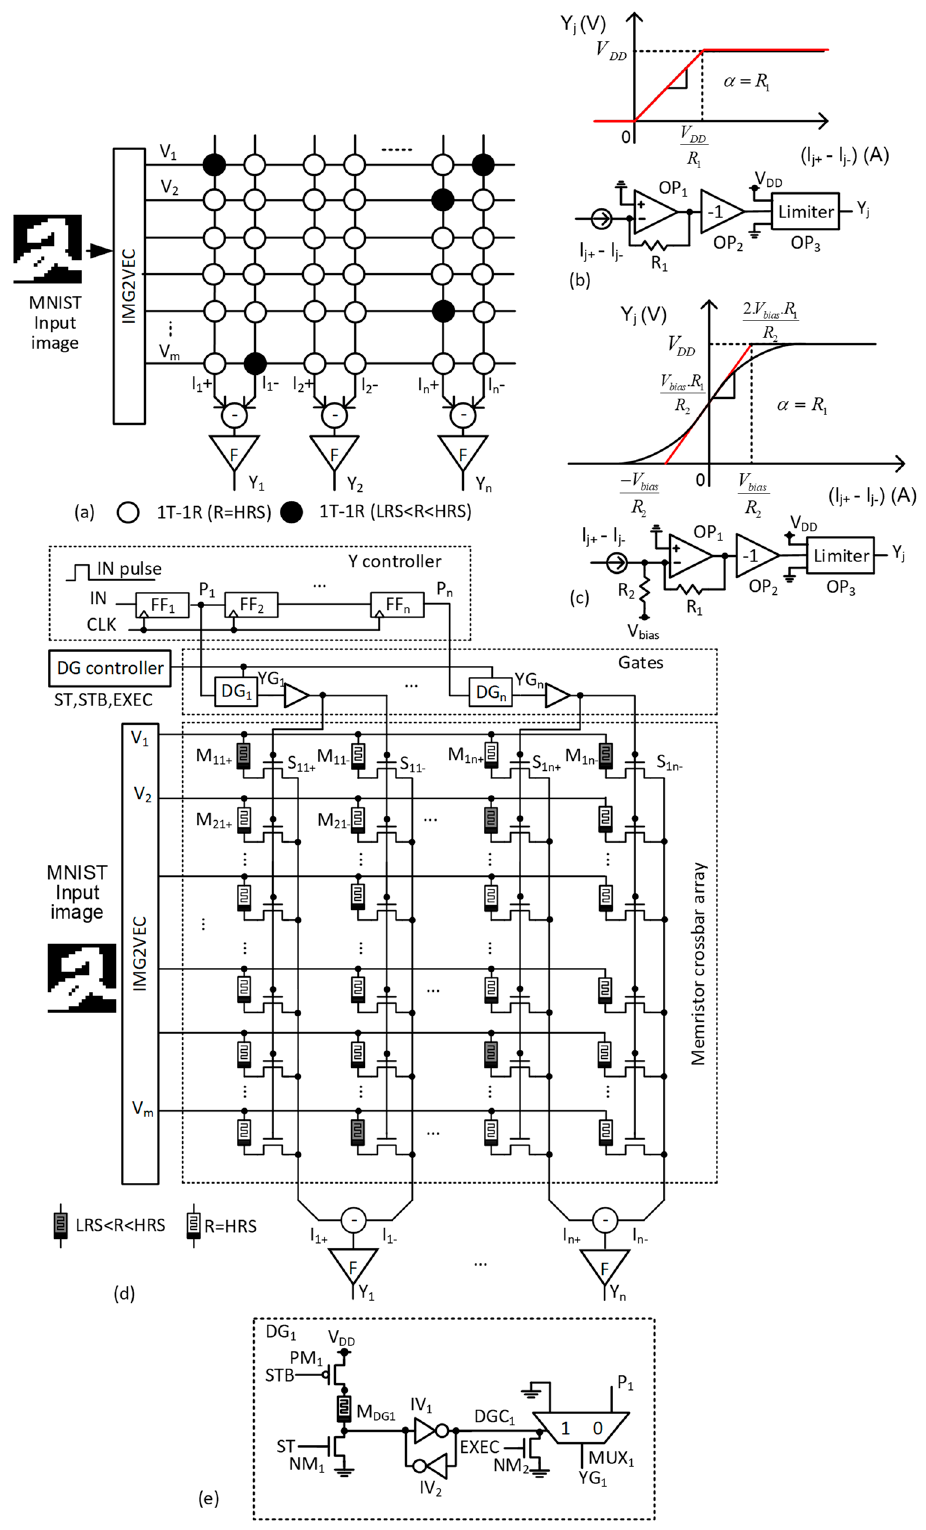
Figure 3. ( a ) The previous 1T-1R memristor crossbar without the partial gating, ( b ) the ReLU activation function circuit and its transfer curve [24], ( c ) the Sigmoid activation function circuit and its transfer curve [24], and ( d ) the proposed memristor crossbar circuit with the partial gating ( e ) the partial gating circuit for controlling the selectors.